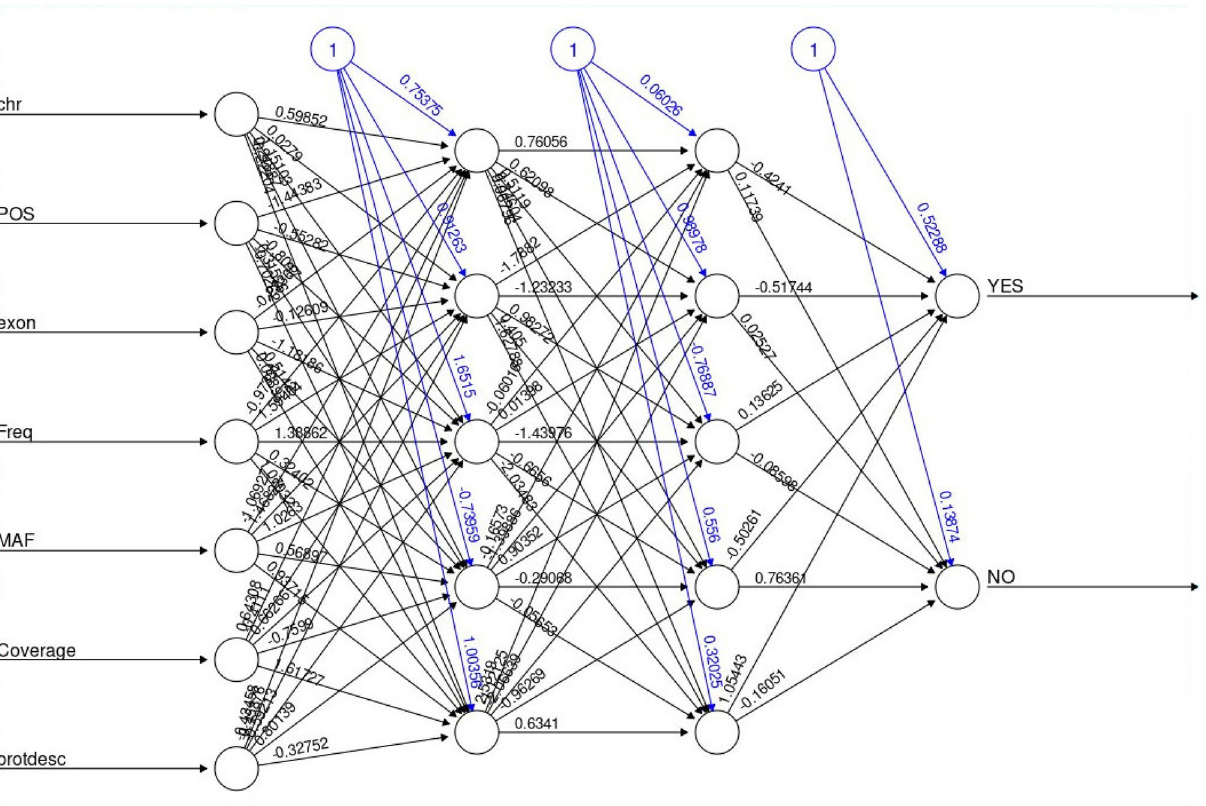
Figure 6. Fully connected artificial neural network (ANN) for oncosomatic variant. It is composed of 7 input features: chromosome number (chr), coordinate position of the chromosome (Pos), exon number, variant allele frequency (Freq), minor allele frequency (MAF), coverage, acid amino change (protdesc), with 2 hidden layers of 5 hidden nodes each. The output is the answer of the ANN, and the output value is YES for pathogenic and NO for benign. In binary representation, YES is coded as 1 for pathogenic and NO coded as 0 for